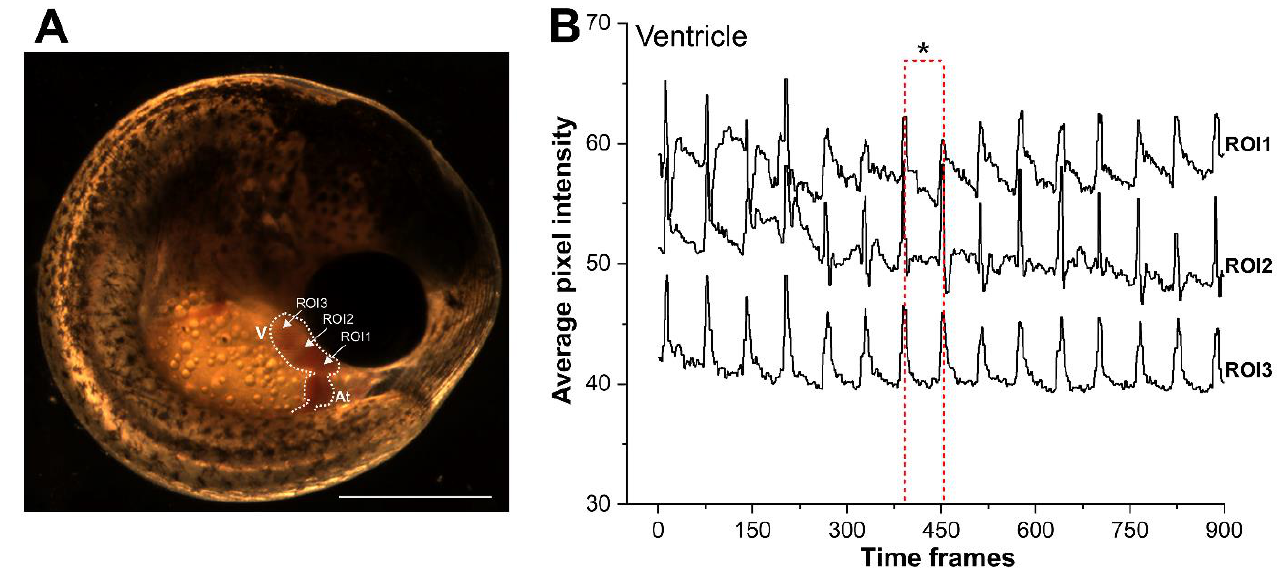
Figure 2. Representative ventricular ROIs with their corresponding light cardiograms (LCGs). The heart (white dotted line) of a developing embryo at ( A ) pharyngula (lateral view) with atrium (At) and ventricle (V) marked. ( B ) Representative graph illustrating the LCGs at three different regions of interest (ROIs) (1–3) within the ventricle. The time interval (marked *) between two consecutive ventricular peaks remained consistent between selected ROIs. The peak and trough in each tracer correspond to ventricular systolic and diastolic phase, i.e., emptying and filling of blood cells, respectively. ROI = region of interest; scale bar = 1